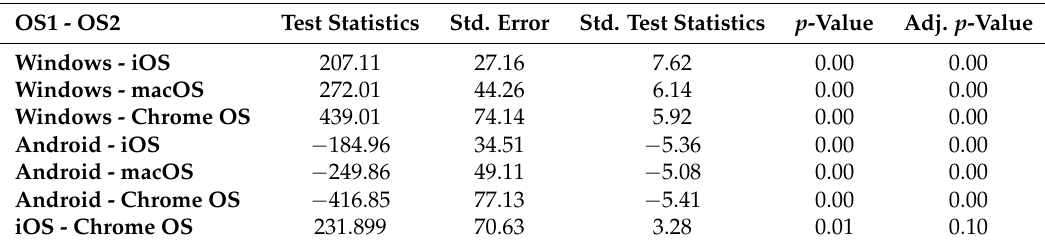
Table 9. Values of the Kruskal-Wallis statistical test and the Bonferroni post-hoc test showing significant differences between the number of passed subjects and the OS used for connections.